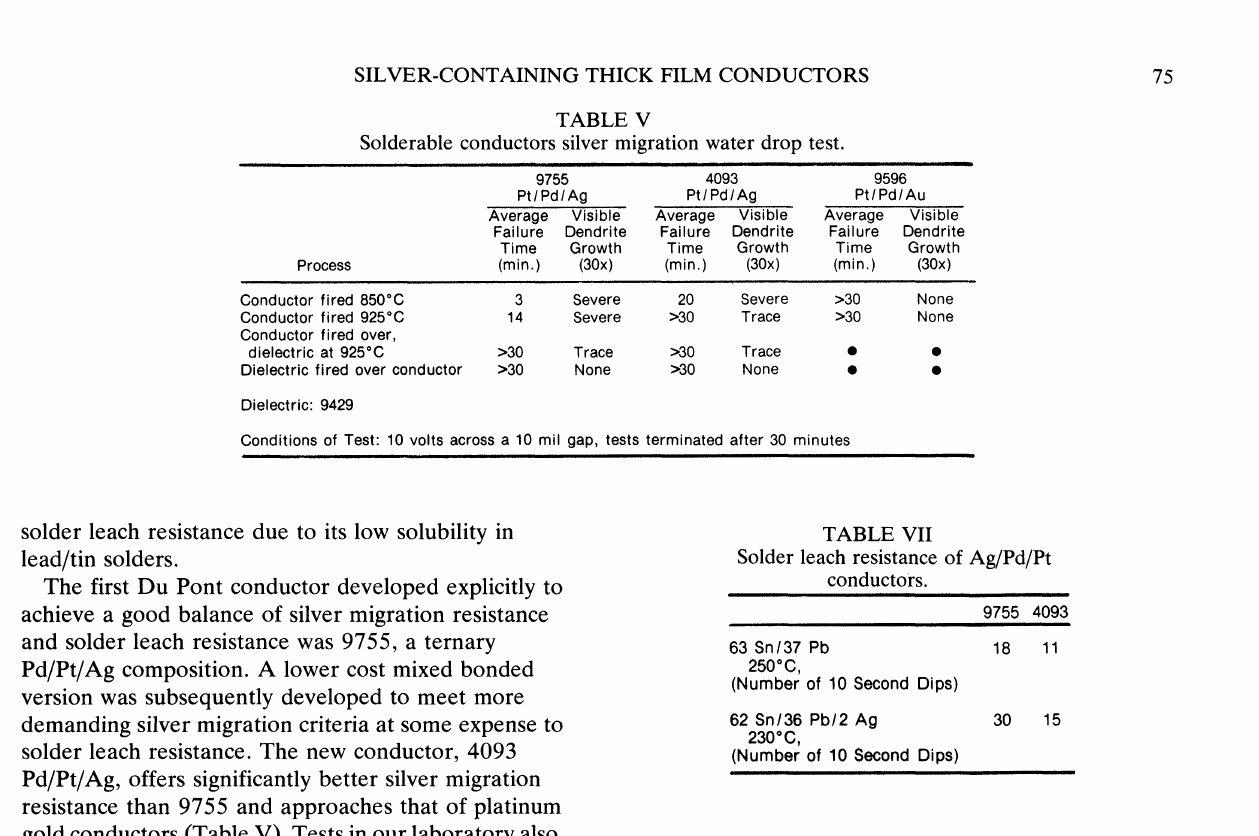
TABLE VII Solder leach resistance of Ag/Pd/Pt conductors.